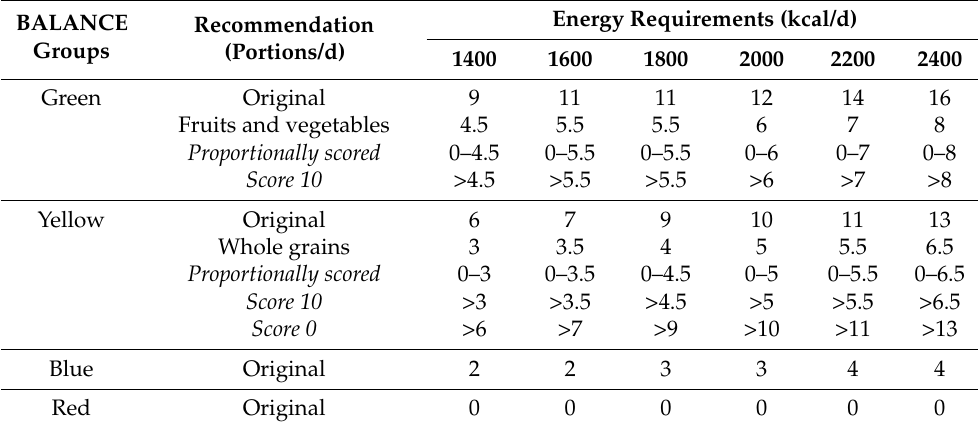
Table 2. Scoring system for the New BALANCE